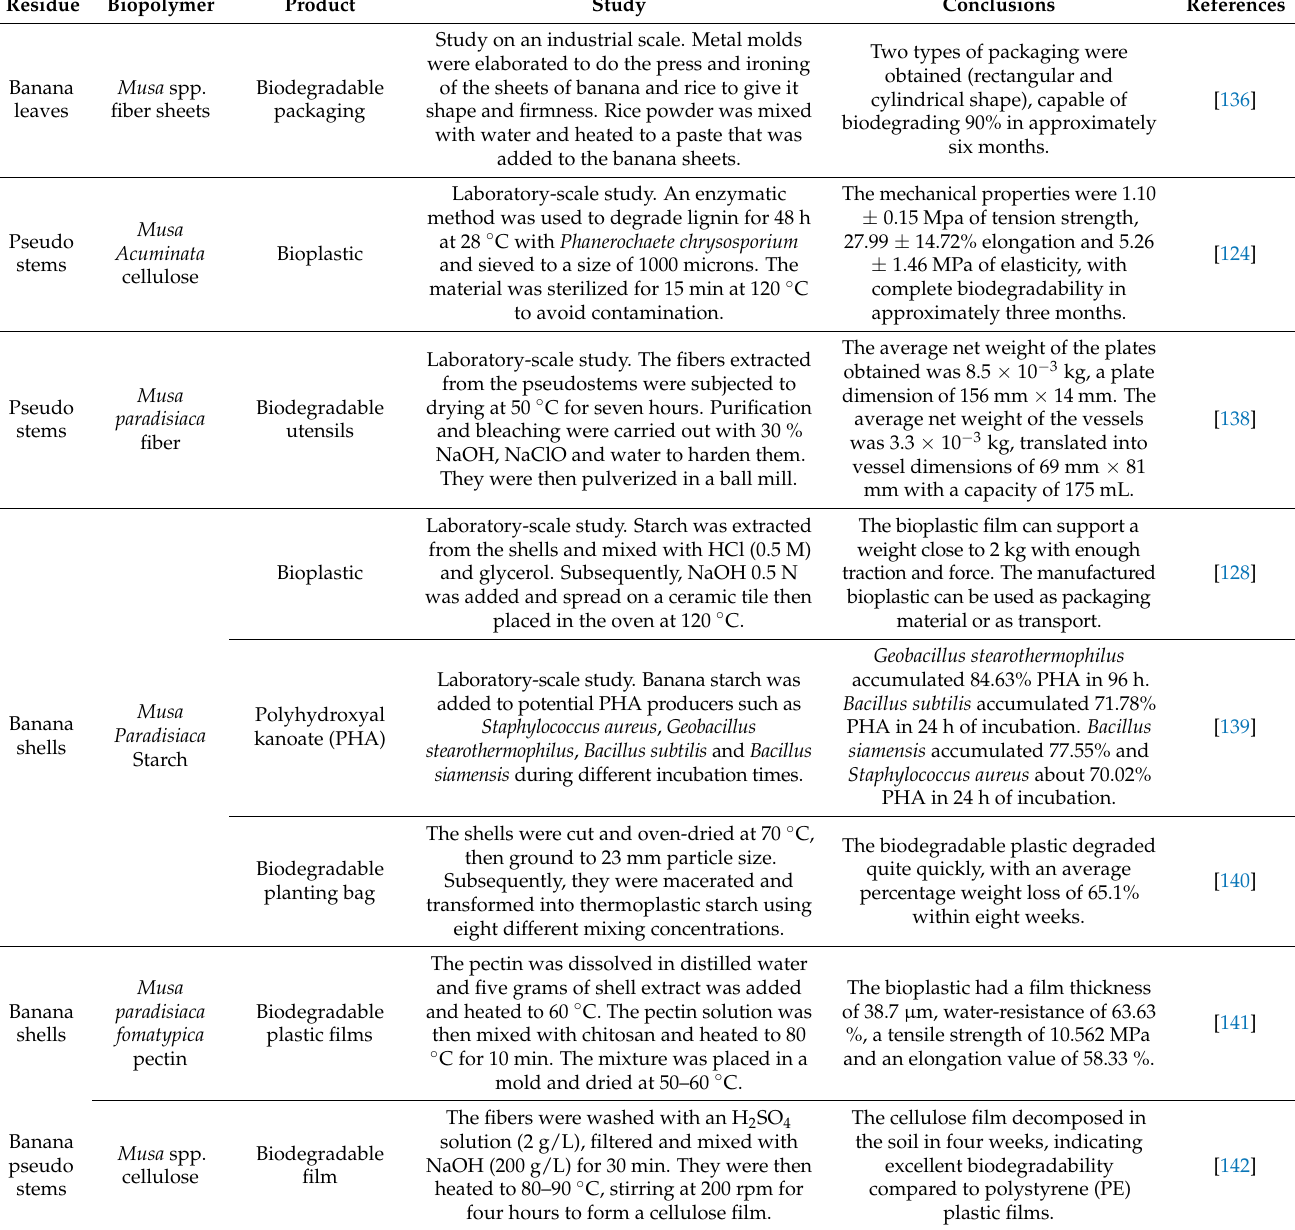
Table 8. Manufacture of bioplastics from banana